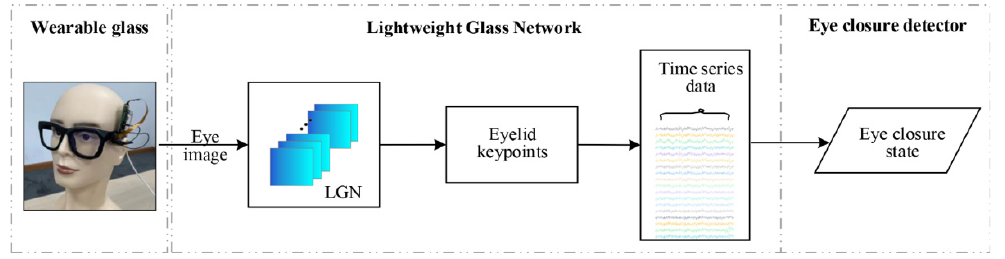
Figure 1. An eye closure monitoring system based on an in ‐ house glass prototype and LGN. Wearable glass prototype: At the core of this system is a wearable glass device that captures images of the eye area in real ‐ time. The lens of the glass was replaced by a hot mirror to allow images of the eye to be captured by an RGB camera installed on the temple of the glass (see Figure 2). The RGB camera has an infrared filter, much like in a traditional video ‐ based eye tracker, except that the camera is close to the eye and sits by instead of in front of the eye. ( b ) Figure 2. The hardware structure and the optical path of the wearable glass prototype. ( a ) Key components of the wearable glass; ( b ) The optical path of the camera. Lightweight Glass Network: The eye image is processed by a compact data pro ‐ cessing unit and then forwarded to a lightweight deep learning network. For convenience, we will refer to this network as a Lightweight Glass Network, or LGN for short. For pri ‐ vacy considerations, the RGB camera was set to record low ‐ resolution images, so it will not have a clear view of the iris. The LGN outputs 6 keypoints that mark the boundary of the eyelids, with which the eye area not covered by the eyelids is estimated and streamed as time series data. Eye closure detector: Eye closure states, most notably blink, are monitored based on the size or the aspect ratio of the eye area. The workflow of the proposed system is briefly summarized in Algorithm 1. As shown in Algorithm 1, real ‐ time images obtained with the RGB camera and the hot mirror are first resized and normalized to meet the input requirements of the LGN. The LGN will output Gaussian probability maps ( E G ), and the eyelid keypoints ( E k ) are extracted based on the highest probability pixels of E G . Then, the open eye area ( S k ) is calculated and stored along with a time label ( S kt ). Finally, eye closure measures, e.g., eye blinks ( E b ), can be extracted from the open eye area sequence.